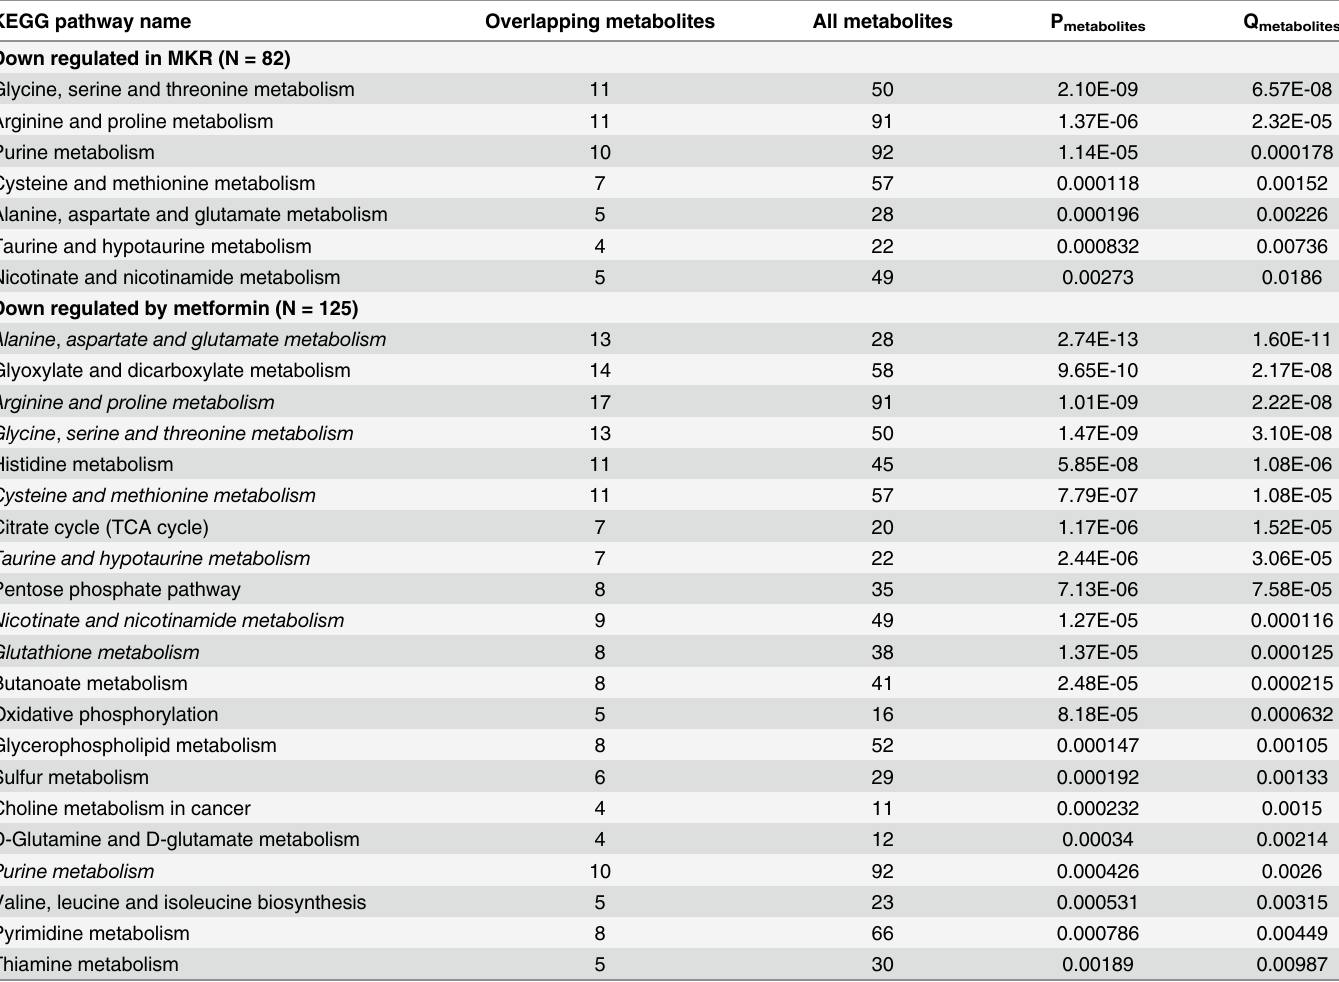
Table 2. Pathway enrichment analysis of metformin-suppressed metabolites from MKR